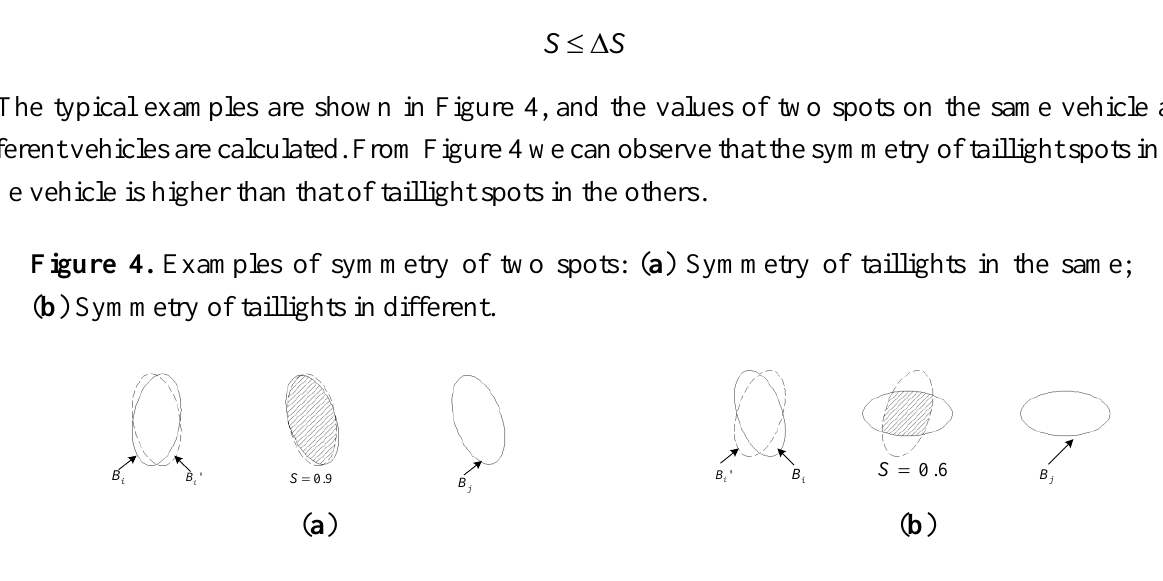
Figure 5. Result of taillight pairing based on the similarity analysis: ( a ) Original image; ( b ) Result of taillight